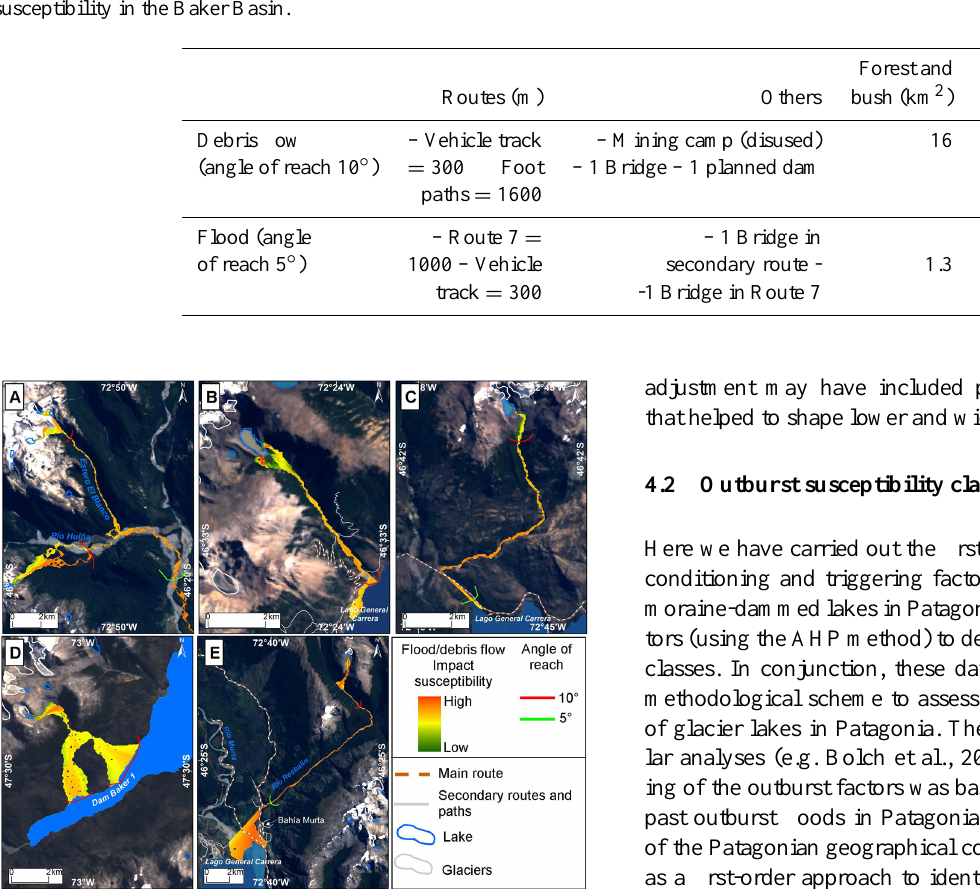
Table 5. Potential damages caused by debris flows and floods originated from moraine-dammed lakes with high or very high outburst susceptibility in the Baker Basin.